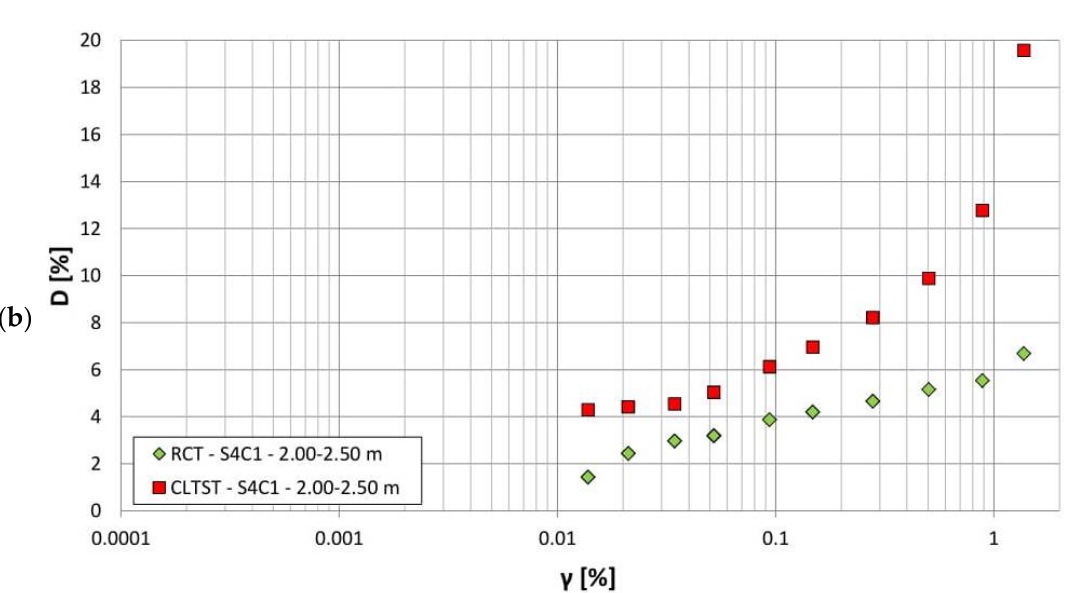
Figure 9. ( a ) G [MPa] versus γ [%] curves. ( b ) D [%] versus γ [%] curves (for the S4C1 soil sample).